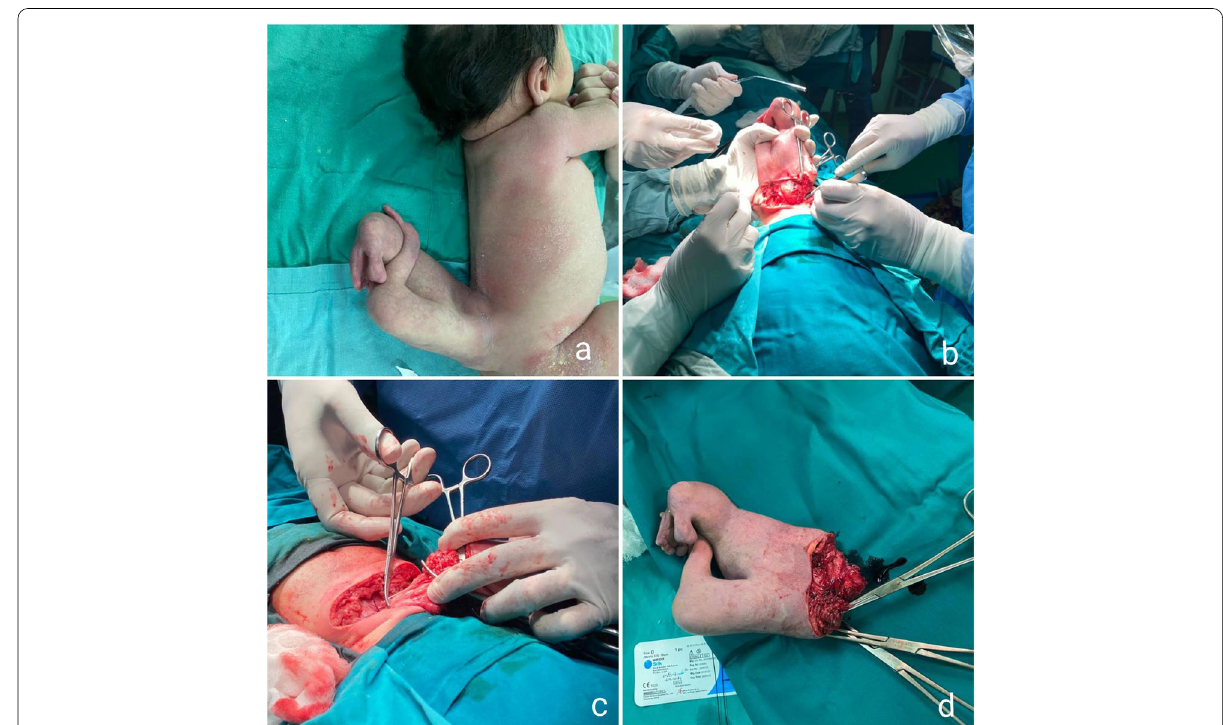
Fig. 2 a Parasitic limb can be seen. b Incision made around the parasitic limb. c Dissection of the limb being done. d Parasitic limb after complete